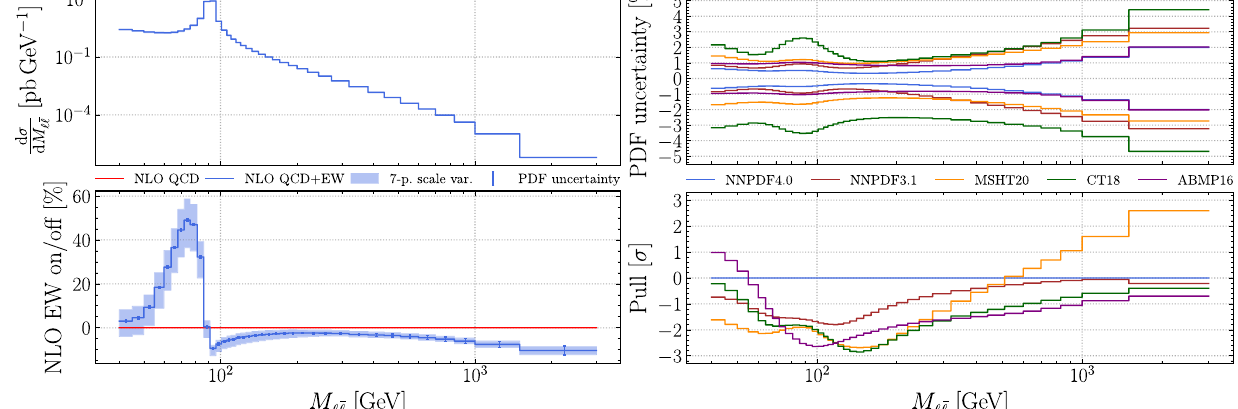
Fig. 65 Same as Fig. 63 for pp → (cid:5) ¯ (cid:5) + X